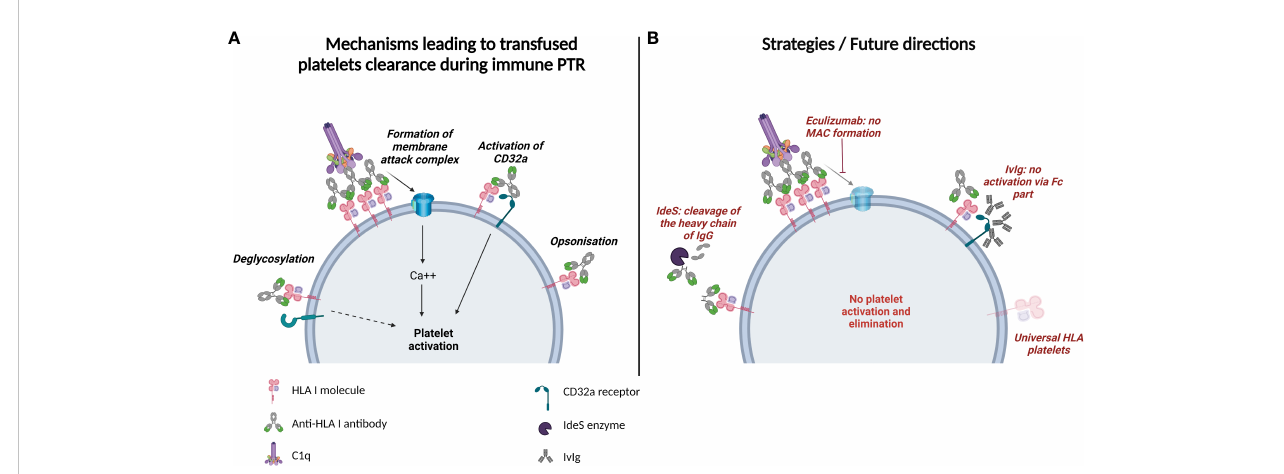
FIGURE 1 Mechanisms of platelet elimination and prospective therapies in HLA Class I-alloantibody-mediated PTR. (A) Potential mechanisms leading to transfused platelets clearance during immune platelet transfusion refractoriness. Anti HLA Class I-alloantibodies can opsonize platelets or lead to their activation via deglycosylation, formation of membrane attack complex or CD32a receptor mobilization. (B) Strategies/Future directions in platelet transfusion refractoriness: cleavage of the heavy chain of IgGs by IdeS enzyme, inhibition of the membrane attack complex formation with Eculizumab, inhibition of Fc receptor mobilization with IvIg, and transfusion of universal HLA platelets that do not express HLA molecules on the